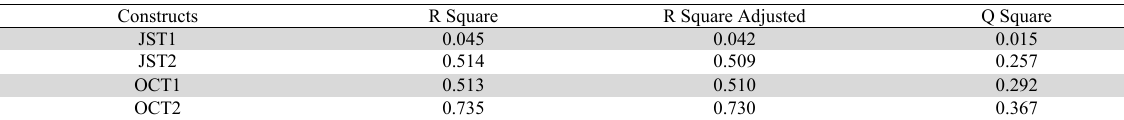
The PLS method Coefficient of determination